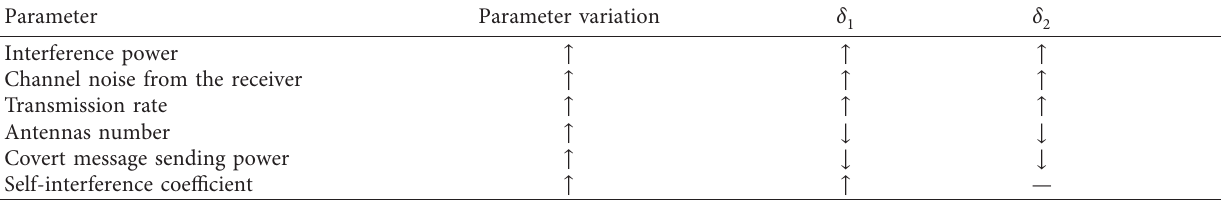
Table 2: Transmission outage probability results.